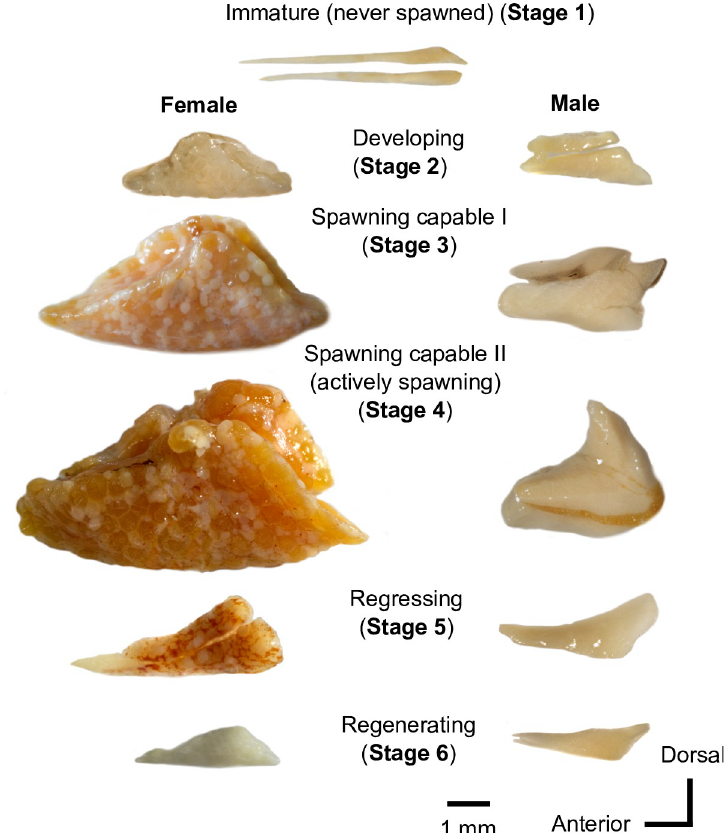
Fig 2. Gonads of Brachyhypopomus at the maturational stages described in Table 1. All images are from B . beebei , with the left side of each gonad pair in lateral aspect (only the left gonad is shown for male Stage 5). Black arrow indicates position where genital duct exits gonad and the point at which the gonads are severed in dissection. Gonads are scaled to the mean size for ca. 20 individuals of each sex and stage. Images were taken using the CamLift and Zerene software system described in